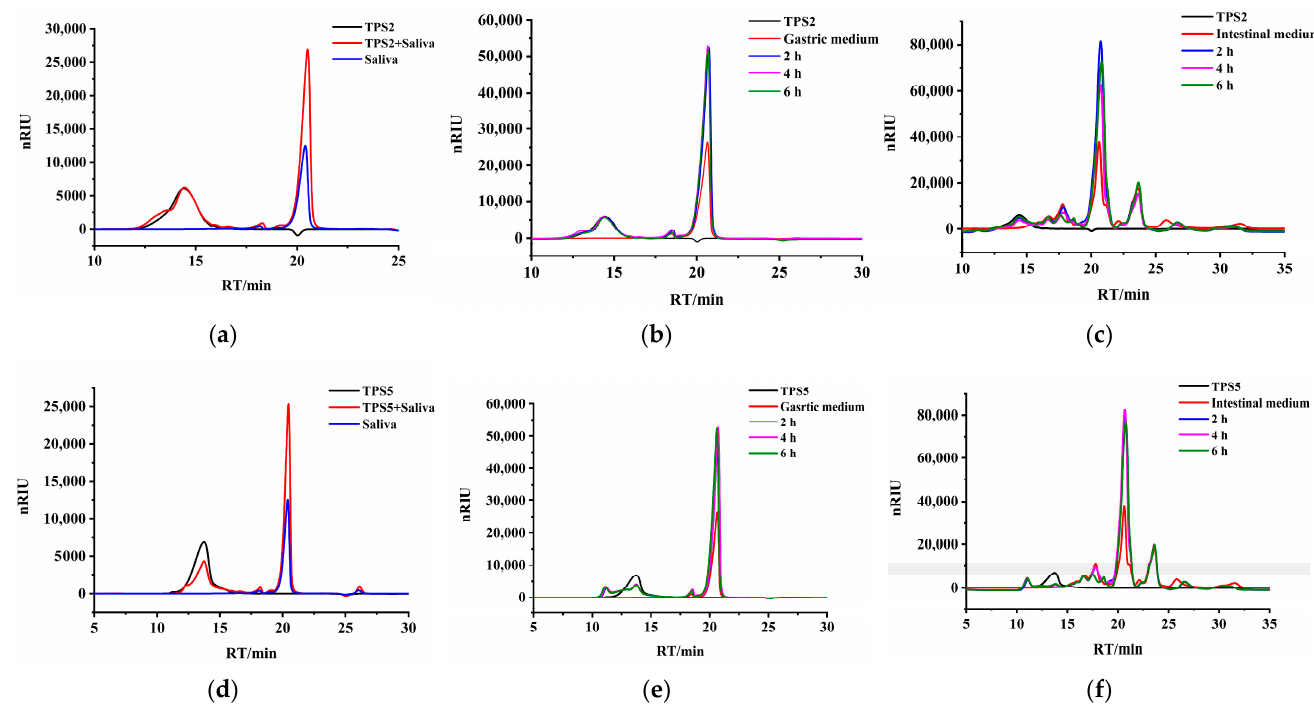
Figure 2. HPGPC chromatograms of TPS2 before and after simulated saliva ( a ), stomach ( b ), and small intestinal ( c ) digestion. HPGPC chromatograms of TPS5 before and after simulated saliva ( d ), stomach ( e ), and small intestinal ( f ) digestion. Table 2. Molecular weights and concentrations of reducing sugars of TPS2 and TPS5 during in vitro simulated saliva–gastrointestinal digestion.